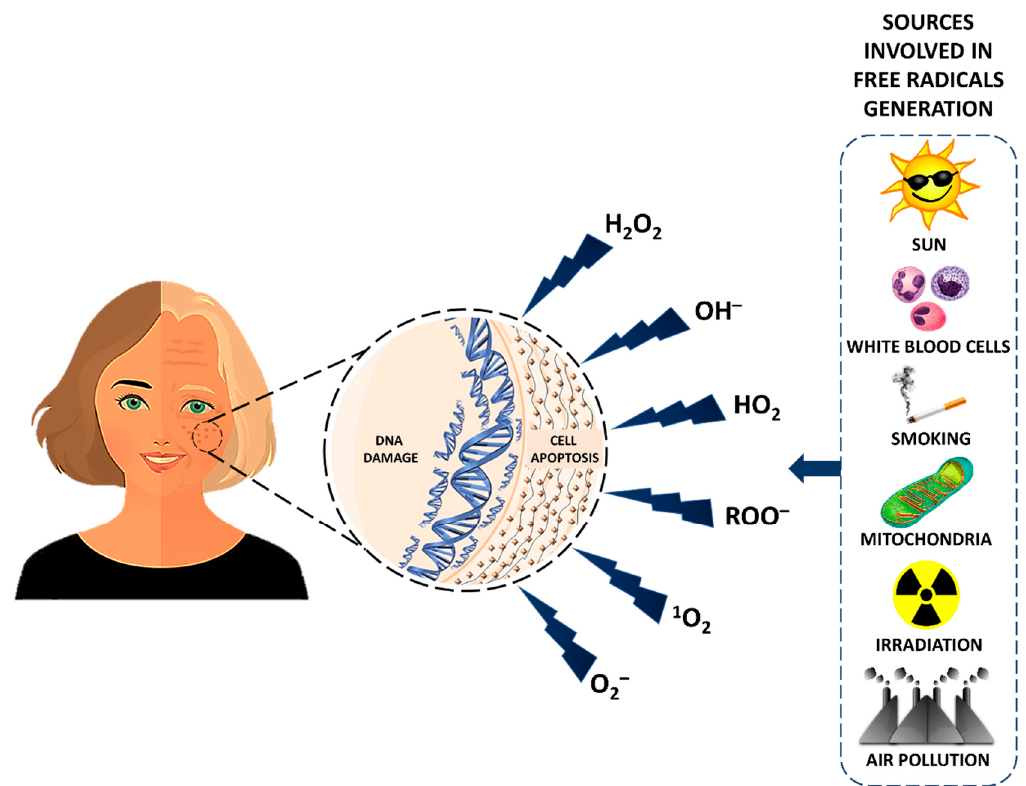
Figure 2. Schematic representation of sources involved in the formation of free radicals and their association with the ageing process.